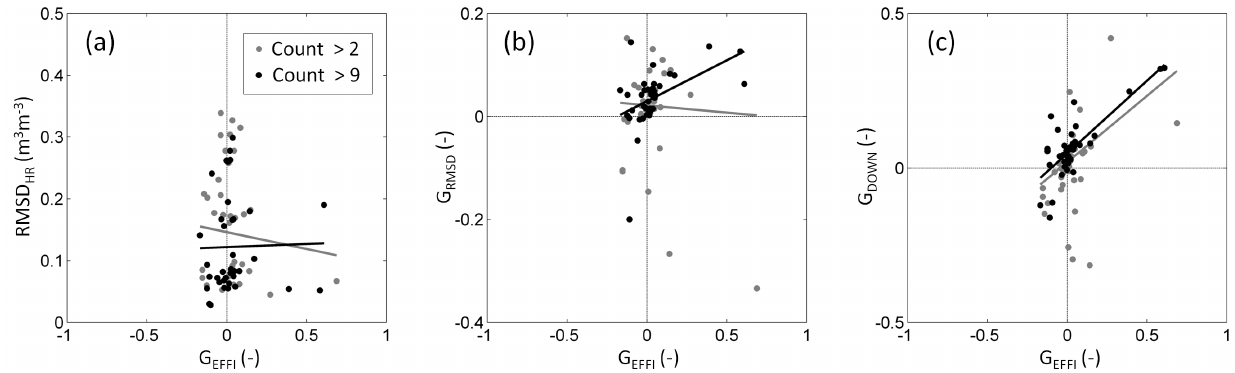
Figure 8. Performance metrics ( a – c ) vs. the disaggregation gain on the bias in the slope of the linear fit (G ) for datasets with a minimum sample count of three and 10 separately. EFFI